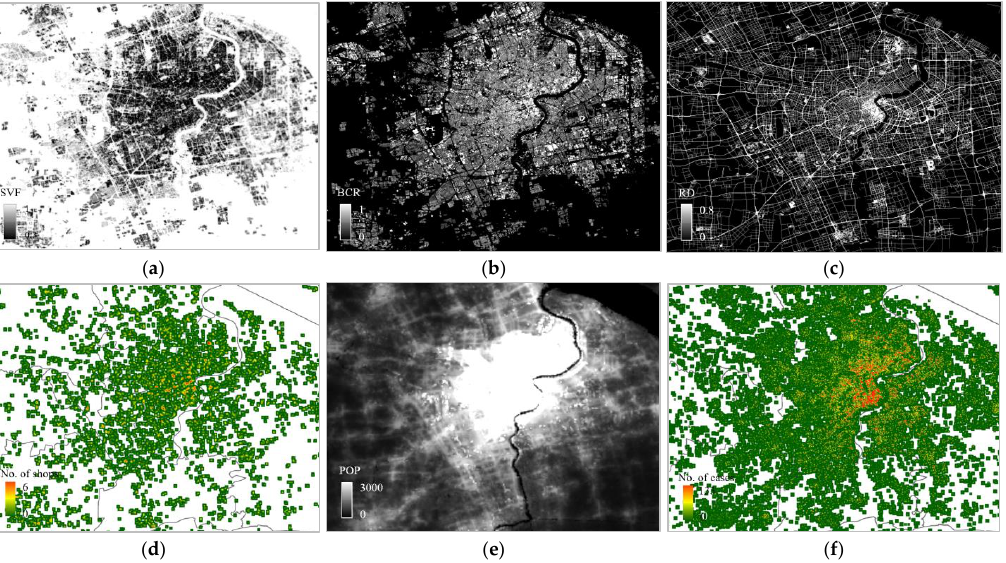
Figure 4. Sample data for Shanghai: ( a ) Sky view factor; ( b ) building coverage ratio; ( c ) density of roads; ( d ) density of shops; ( e ) population density; ( f ) number of infection cases as a measure of infection rate.